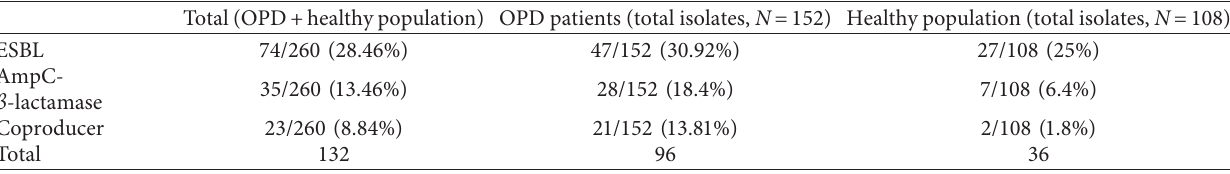
Table 2: Distribution of β -lactamases in different clusters of sample.